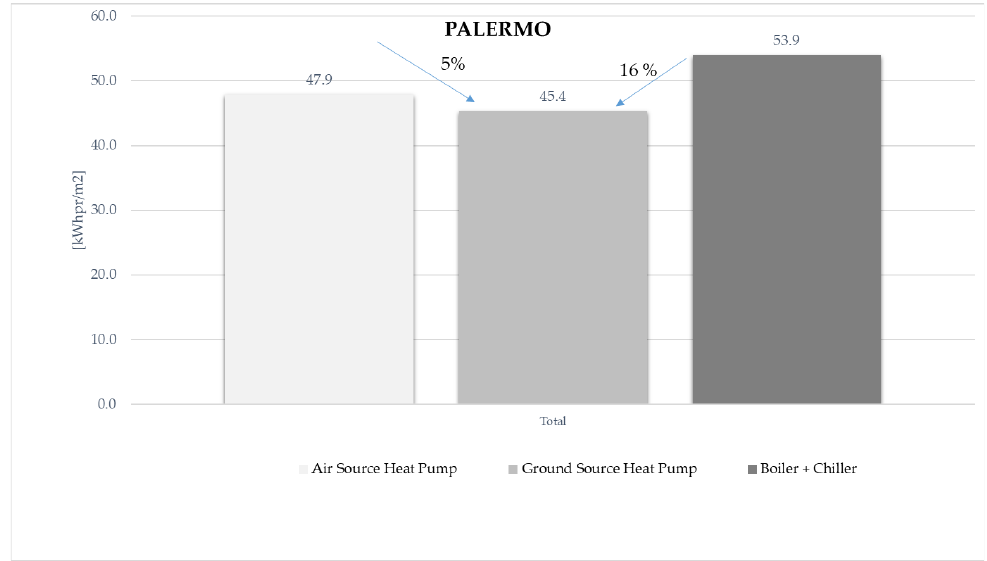
Figure 5. Primary energy demand (kWh/m 2 y) for the three different proposed systems in the case of Milan.